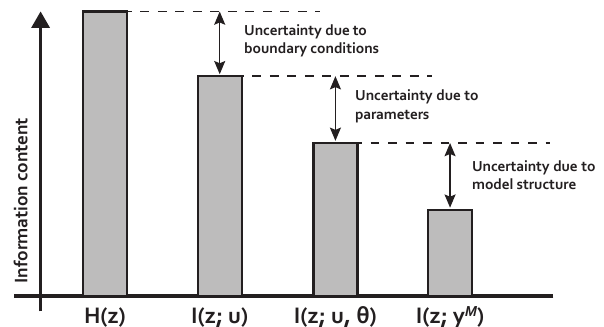
Figure 3. A conceptual diagram of uncertainty decomposition us- ing Shannon information following Nearing et al. (2016). The term H(z) represents the total uncertainty (entropy) in the benchmark ob- servations, and I(z ; u) represents the amount of information about the benchmark observations that is available from the forcing data. Uncertainty due to forcing data is the difference between the to- tal entropy and the information available in the forcing data. The information in the parameters plus forcing data is I(z ; u) , and I(z ; u,θ) < I(z ; u) because of errors in the parameters. The term I(z ; y M ) is the total information available from the model, and I(z ; y M ) < I(z ; u,θ) because of model structural